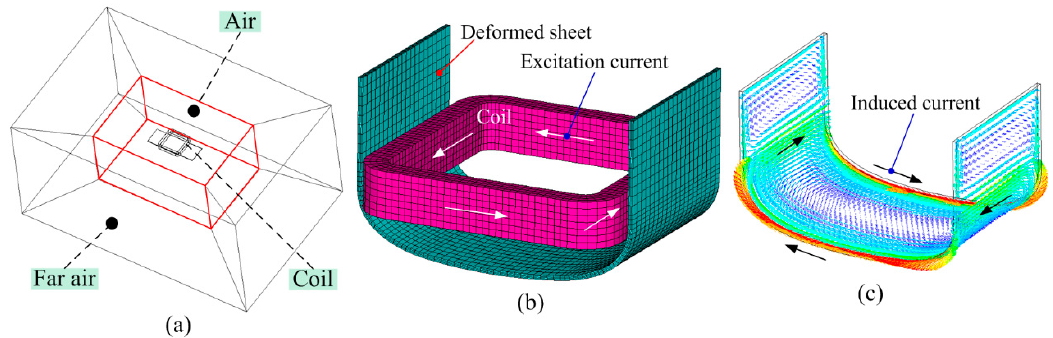
Figure 3. Field analysis of the ( a ) electromagnetic field model; ( b ) updated model of the sheet and the coil; and ( c ) induced current on the sheet metal.